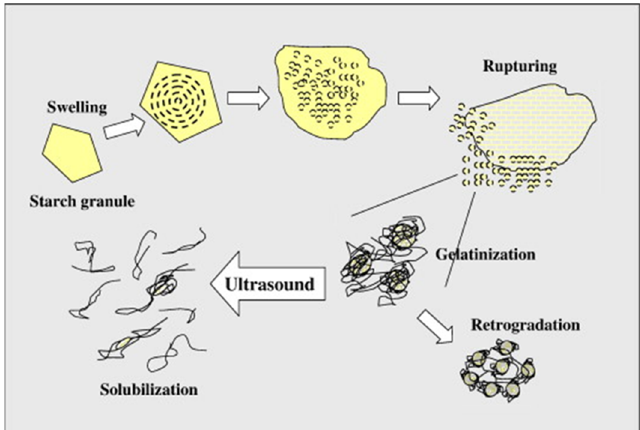
Figure 8. An illustration of the starch granule swelling, gelatinization, and depolymerization process [38]. Reprinted/adapted with permission from Ref. [38]. 2008, Elsevier, License Number 5400560644122.